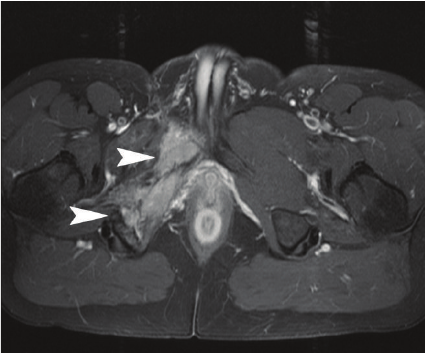
Figure 2: Gadolinium enhanced axial T1 CT (December 2005) of the pelvis with fat saturation demonstrates postsurgical change and irregularity of the right inferior pubic ramus, with an adjacent associated enhancing soft tissue mass (arrows).